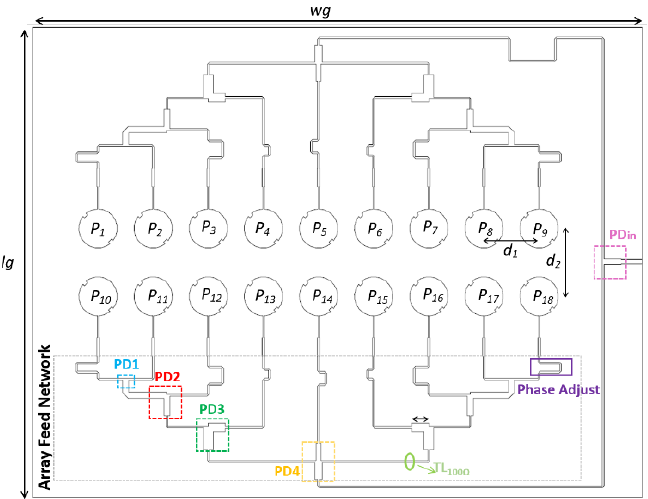
Figure 8. Antenna array structure.